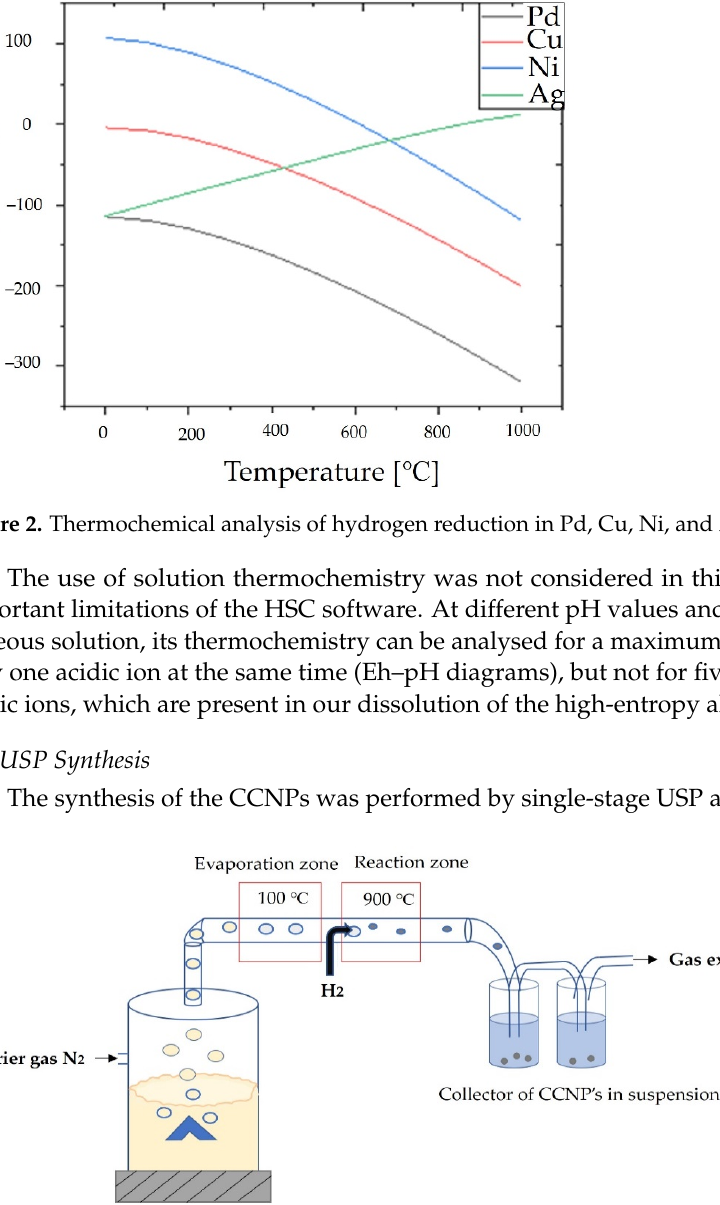
Figure 3. Schematic representation of CCNPs’ synthesis via USP.